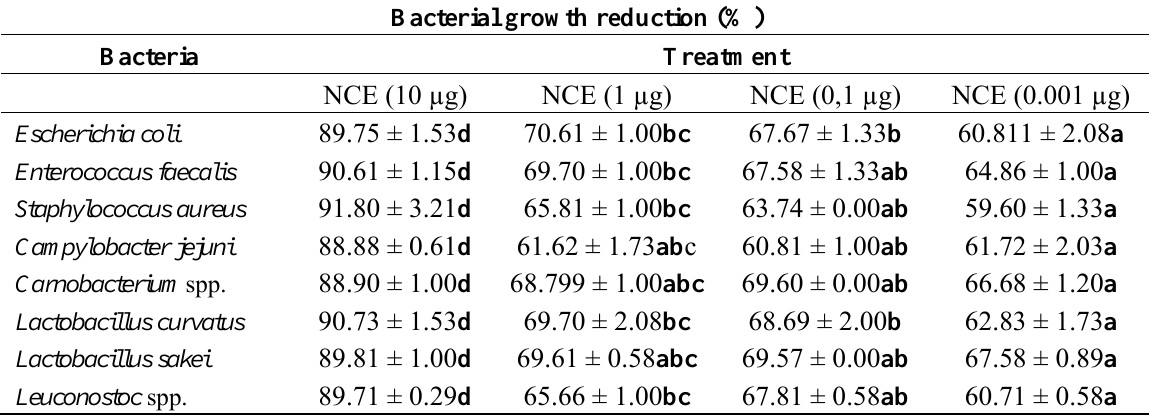
Table 2. Bacterial growth inhibition (%) at 24 h in liquid medium with different concentrations of NCE using as reference the control treatment (without NCE).